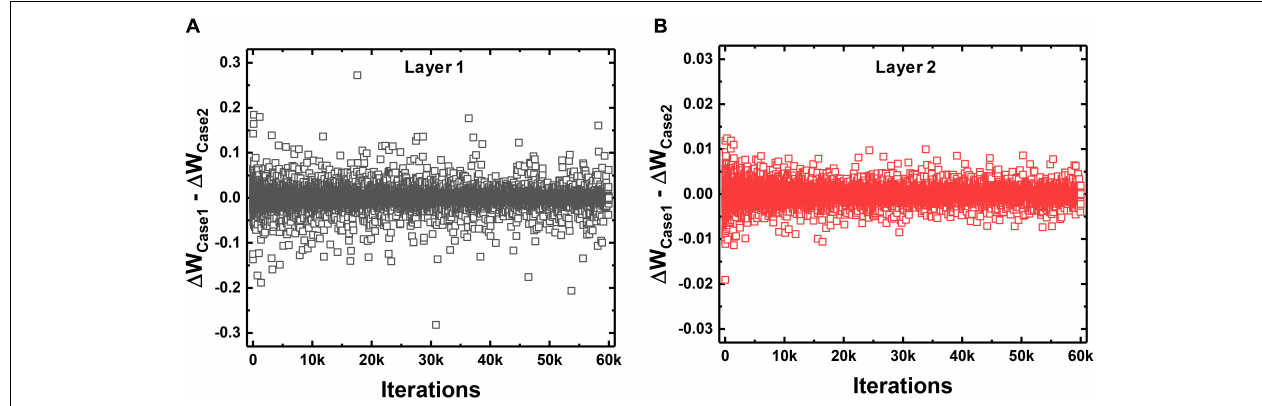
FIGURE 7 | Comparison between the updating method that uses only a 1-bit spike event at the last time step per neuron (Case 1) and the total number of generated spikes in the neuron divided by the total time step (Case 2). The difference in the sum of total weight updates for Case 1 and Case 2 with respect to the training iterations in (A) the first layer and (B) the second layer.